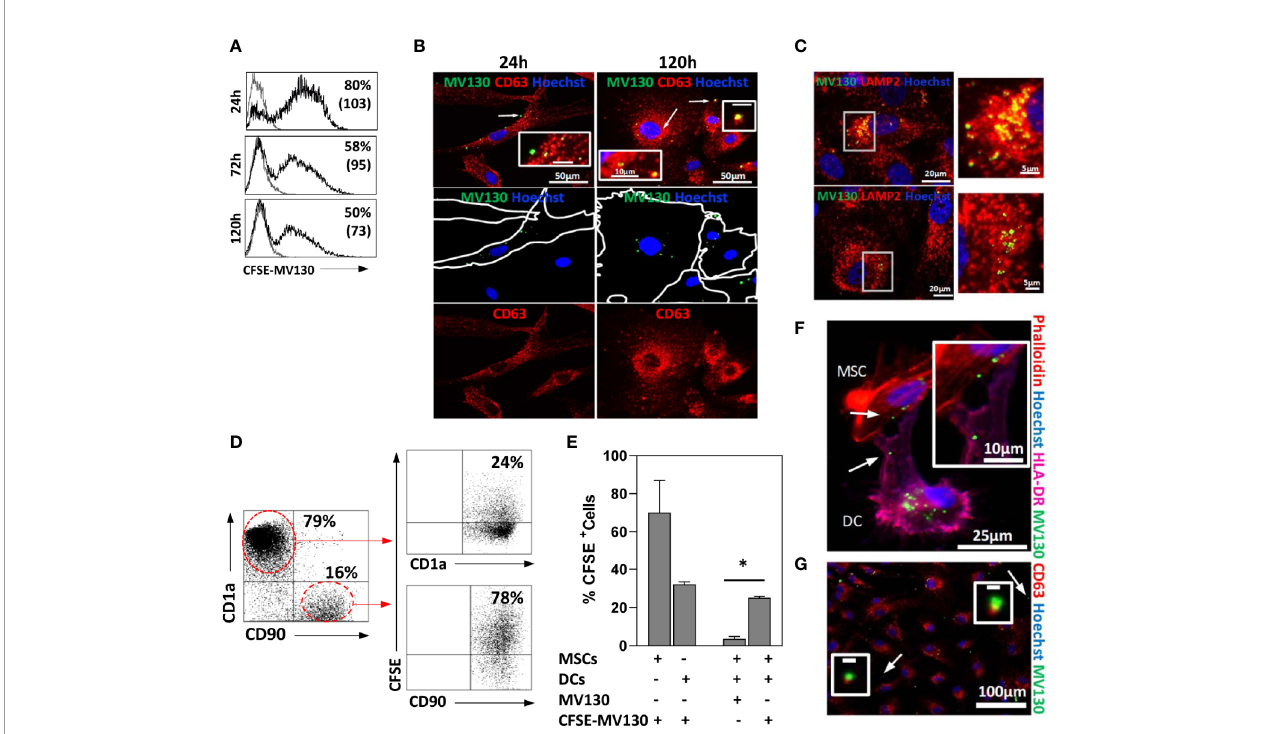
FIGURE 3 | MSCs act as reservoirs of MV130 and are able to transfer it to DCs. MSCs were treated for 24 h with MV130 labeled with CFSE (CFSE-MV130; green) for monitoring. After washing cells to remove the drug, its uptake, processing and transference to DCs were studied. (A) Uptake and maintenance of CFSE-MV130. Histograms show the percentage of positive cells and MFI in brackets (n = 6 – 8 independent experiments). (B, C) Spatiotemporal monitoring of MV130 (green) in MSCs. Immunostaining in red for CD63 (B) or LAMP2 (C) in MV130-MSCs at different times. Inset indicated by arrows in B, scale bar: 10 m m (24 h) or 1 m m (120 h). Right: Higher magni fi cation of the white square in (C) (120 h); examples of LAMP2-positive compartments with CFSE-MV130. Hoechst was used for nucleus staining (blue). Images are representative of 5 independent experiments. (D – G) DCs differentiated from monocytes were co-cultured with MSCs, previously treated with MV130 or CFSE-MV130 as described in Material & Methods section, and transfer of MV130 from MSCs to DCs was studied. A representative dot plot (D) and the mean ± SEM of fi ve independent experiments (E) are shown. DCs and MSCs were gated according to CD1a or CD90 expression, respectively. In (E) control MSCs and DCs directly treated with CFSE-MV130 are also shown. (F) MV130 transfer from MSCs to DCs studied by immuno fl uorescence. Hoechst was used for nucleus staining in all cases (blue). Co-cultures were labeled with phalloidin (red) and anti-HLA-DR (magenta). The absence of HLA-DR expression on MSCs allow to distinguish it from DCs (HLA-DR + ). White arrows in (F) indicate area of insert image magni fi cation. (G) MSCs were labeled with anti-CD63 (red) and Hoechst was used for nucleus staining (blue). Co-localization of CD63 + extracellular microvesicles with CFSE-MV130 was observed free in the medium. White arrows indicate area of insert image magni fi cation. Representative images of 3 independent experiments (*p < 0.05 signi fi cance by Wilcoxon